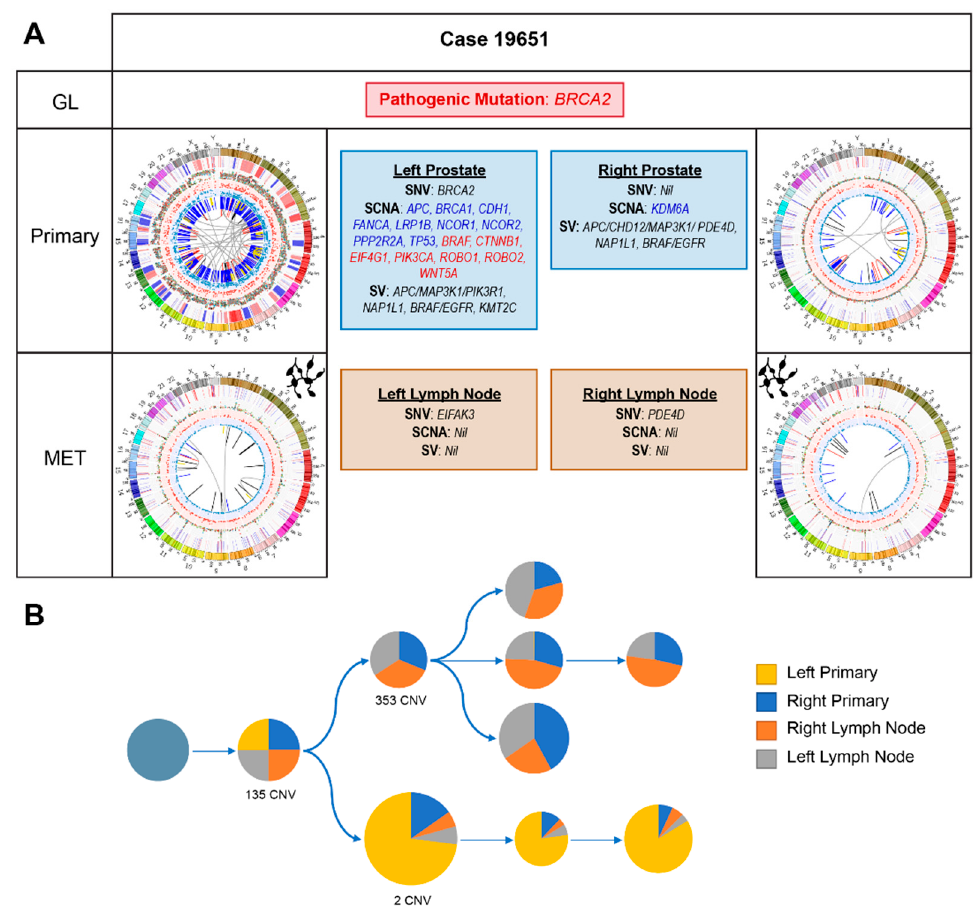
Figure 4. Case 19651. ( A ) Summary of relevant genomic alterations (germline and somatic); Circos plots as per Figure 3. GL: germline mutations; MET: metastases; ( B ) Phylogenetic reconstruction of cancer evolution predicted based on somatic SNV and copy number data. Each circle is a predicted tumour subclone, from the leftmost ancestral clone, with pie charts representing cancer cell fractions (proportion of the four samples harbouring the corresponding clone). Sizes of the circles are proportionate to the number of additional small somatic mutations acquired. Number of SCNAs acquired are indicated.